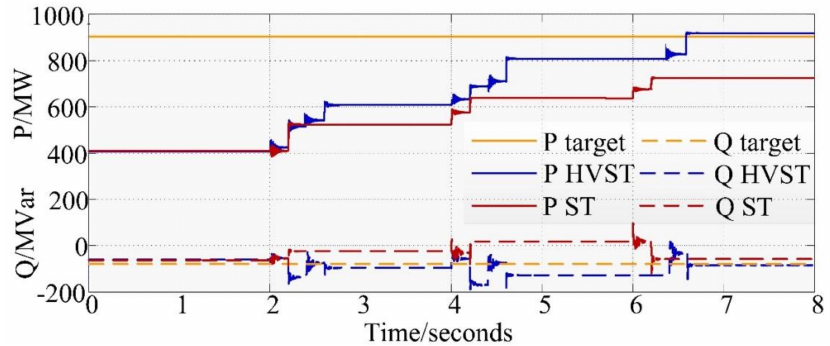
Figure 11. The curves of power flows compensated by the ST or the